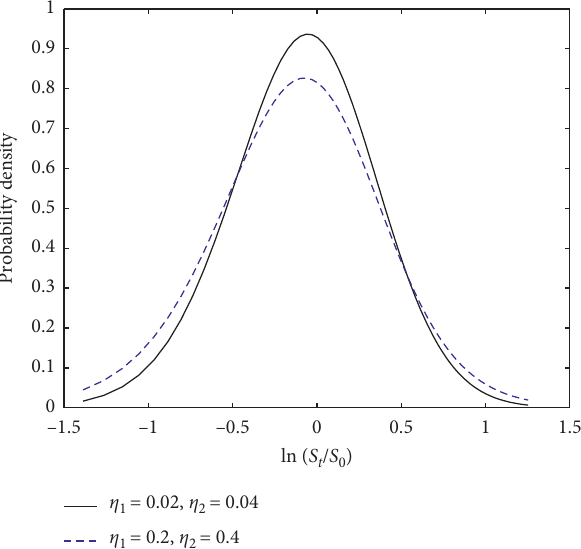
Figure 7: Probability density function with different jump means and η η 1 2